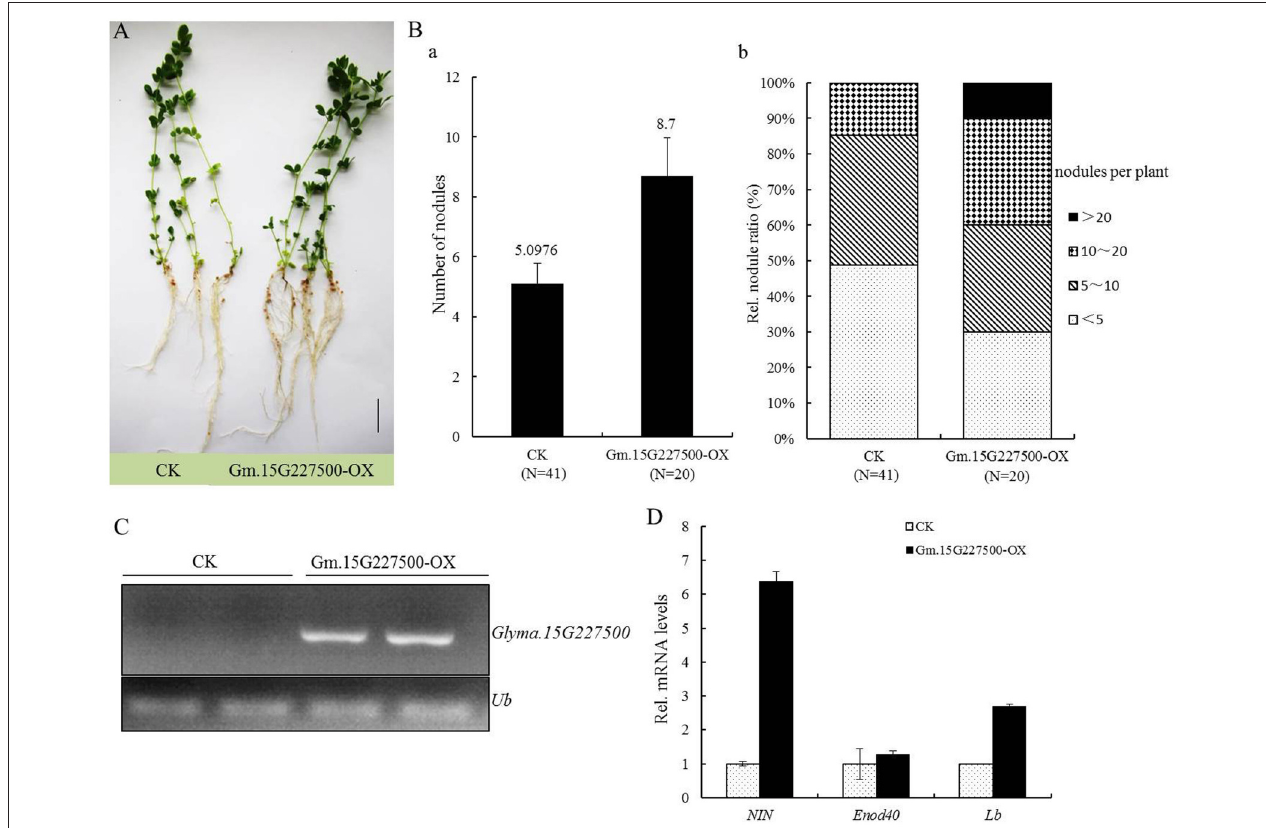
FIGURE 7 | Effect of Glyma.15G227500 overexpression on symbiosis in L. japonicus . (A) Symbiotic phenotypes of transgenic plants at 32 days of post inoculation with M. loti . MAFF303099. Hairy roots expressing vector pU1301 served as a control. Independent transgenic plants were chosen for photography. Bars = 5 mm. (B) Nodule numbers of transgenic hairy roots with altered Glyma.15G227500 transcript levels. Transgenic hairy roots expressing vector (pU1301) served as control. (A) Mean numbers of nodules per plant with standard deviation (SD) of L. japonicus expressing pMUb: Glyma.15G227500 (Gm.15G227500-OX) or the empty vector pU1301 (CK) at 32 days of post inoculation with M. loti . (B) Plants were divided into different groups on the basis of nodules per plant, and the relative ratios of various groups were calculated. (C) Semi-quantitative RT-PCR analysis of the transcript levels of Glyma.15G227500 in the control and Gm.15G227500-OX hairy roots. (D) qPCR analysis of the transcript levels of NIN , Enod40, and Lb in the control and Gm.15G227500-OX hairy roots. Total RNA isolated from root system was used for qPCR. Relative expression levels of NIN , Enod40, and Lb transcripts in Gm.15G227500-OX hairy roots were calculated with reference to that of the control hairy